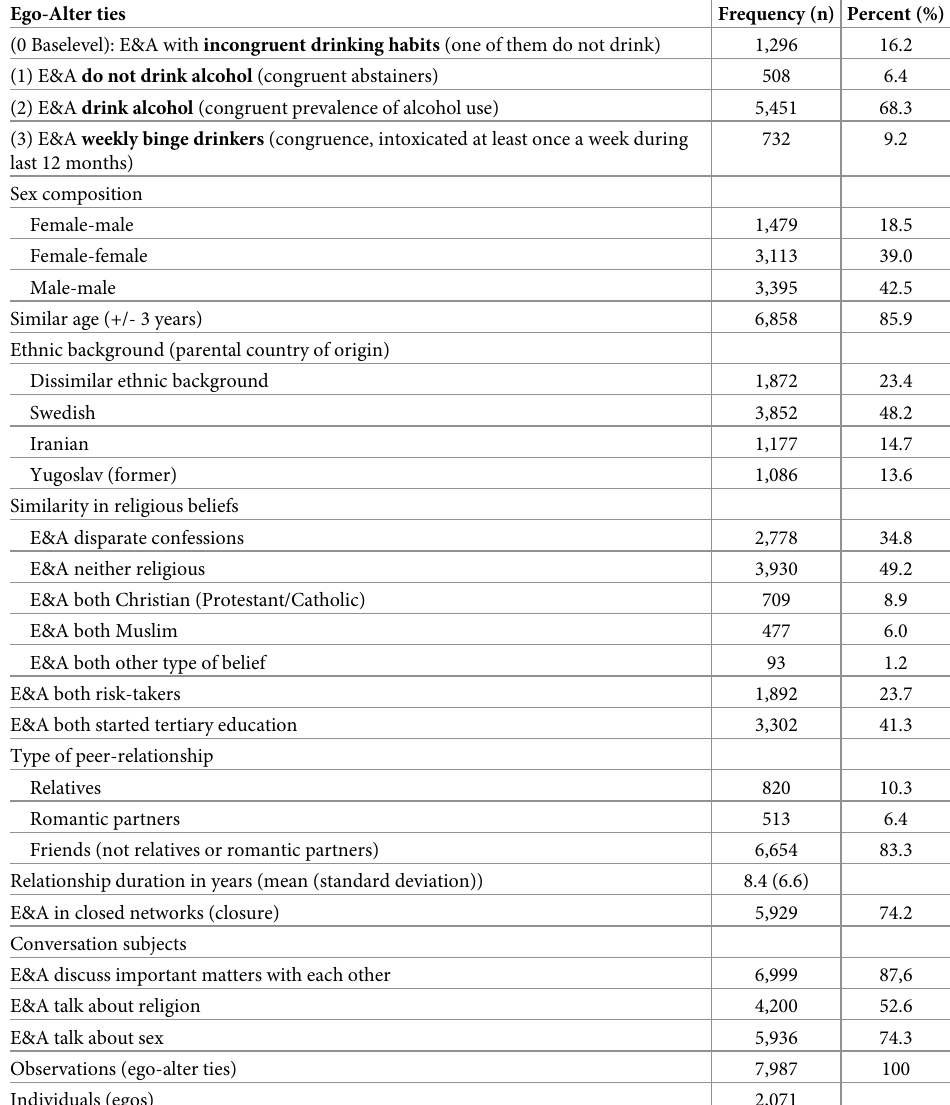
Table 1. Distribution of social network characteristics at the dyad